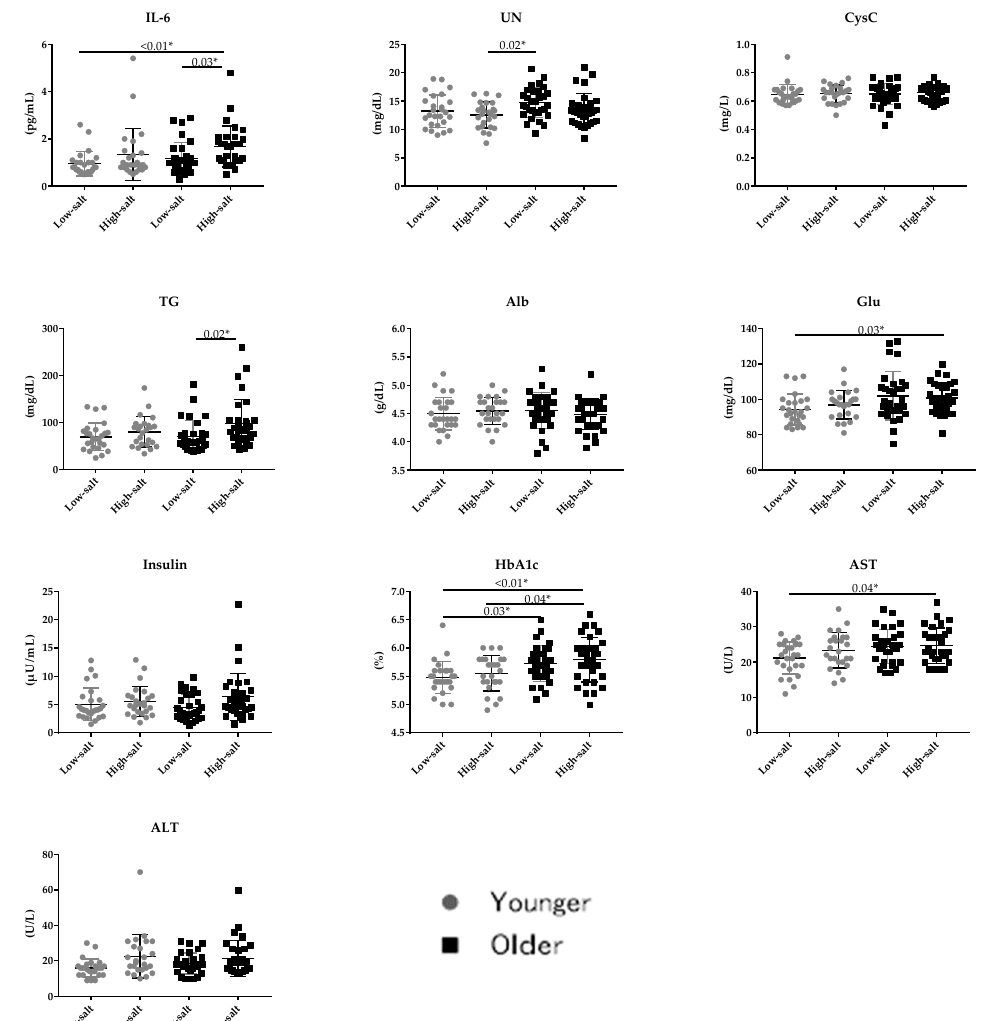
Figure 1. For comparison of the four groups, one-way ANOVA or Kruskal-Wallis test was performed, followed by a post hoc test. *: p < 0.05. sec: seconds, BW: body weight, SBP: systolic blood pressure, DBP: diastolic blood pressure, BMI: body mass index, SMI: skeletal muscle mass index, ULMM: mass of muscle of upper limbs, LLMM: mass of muscle of lower limbs, BFP: body fat percentage, HGS / BW: handgrip strength / weight, KES: knee extensor muscle strength, SLT: single-leg stance time, MGS: maximum gait speed, Flex: long seat type body anteflexion, 30CS: chair rise test, IL-6: interleukin-6, UN: urea nitrogen, CysC: cystatin C, TG: triglyceride, Alb: albumin, Glu: glucose, HbA1c: glycosylated hemoglobin, AST: aspartate transaminase, ALT: alanine